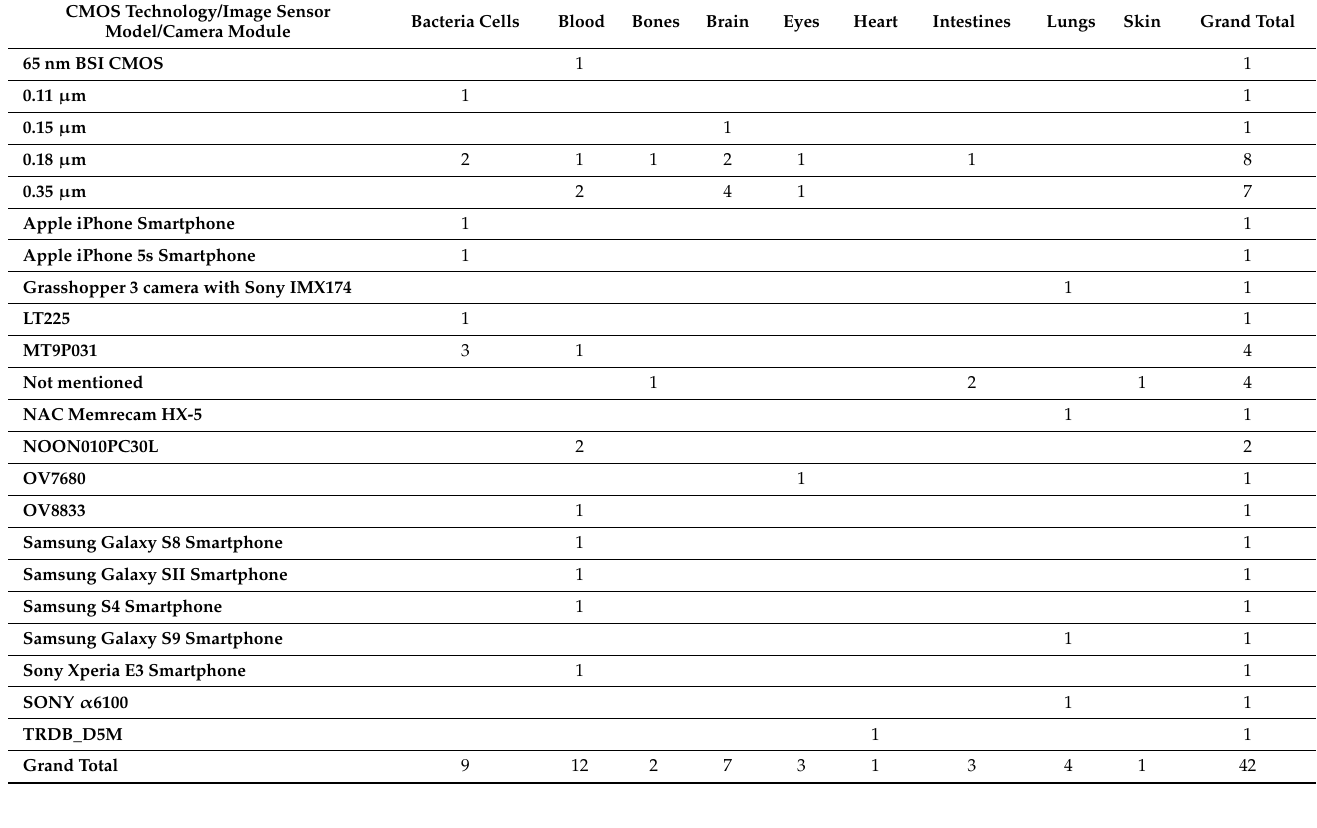
Table 3. The utilization of complementary metal-oxide semiconductor image sensor CIS models in different medical devices performs disease diagnosis of vital signs, organs of the human body.